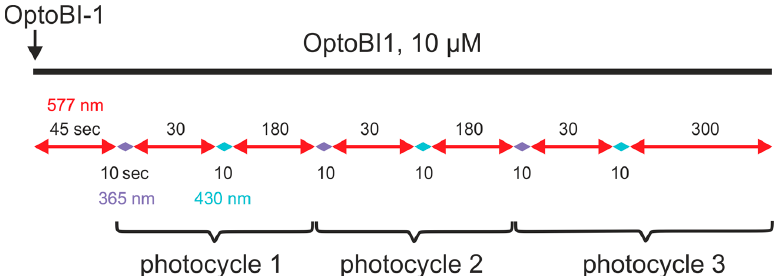
Scheme 1. Schematic representation of OptoBI-1 application and illumination during [Ca 2+ ] i imaging. OptoBI-1 was added before and kept during the whole recording. Light illumination is cycled as indicated in the Scheme 1: Red arrow (577 nm)—detection of R-GECO fluorescence, violet (365 nm)—photoconversion of trans -OptoBI-1 in cis -OptoBI-1, blue (430 nm)—photoconversion of trans -OptoBI-